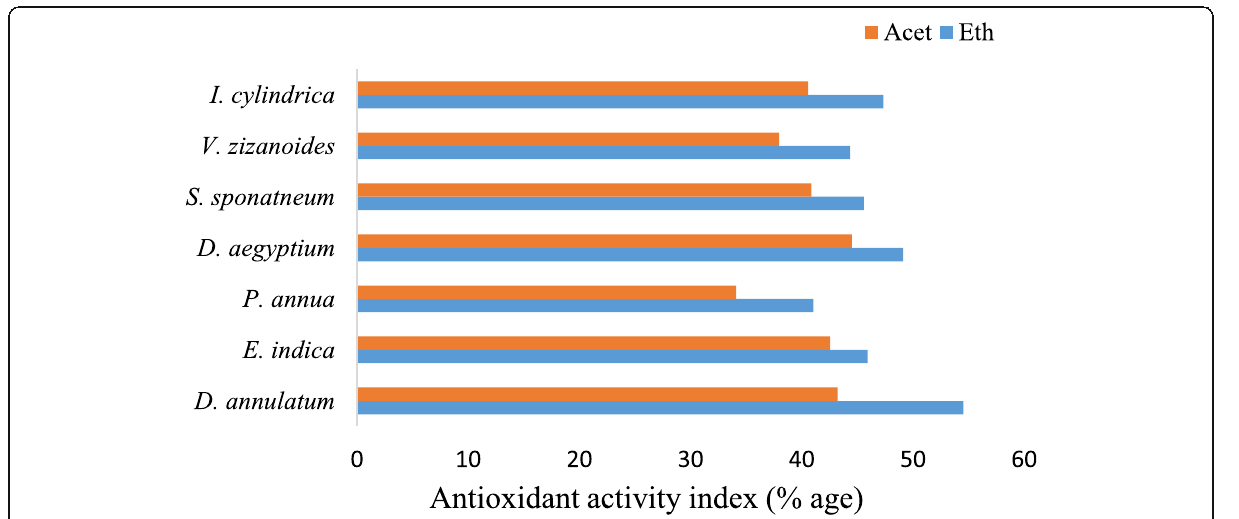
Fig. 3 Antioxidant activity index (AAI) of ethanol and acetone extracts of selected plant